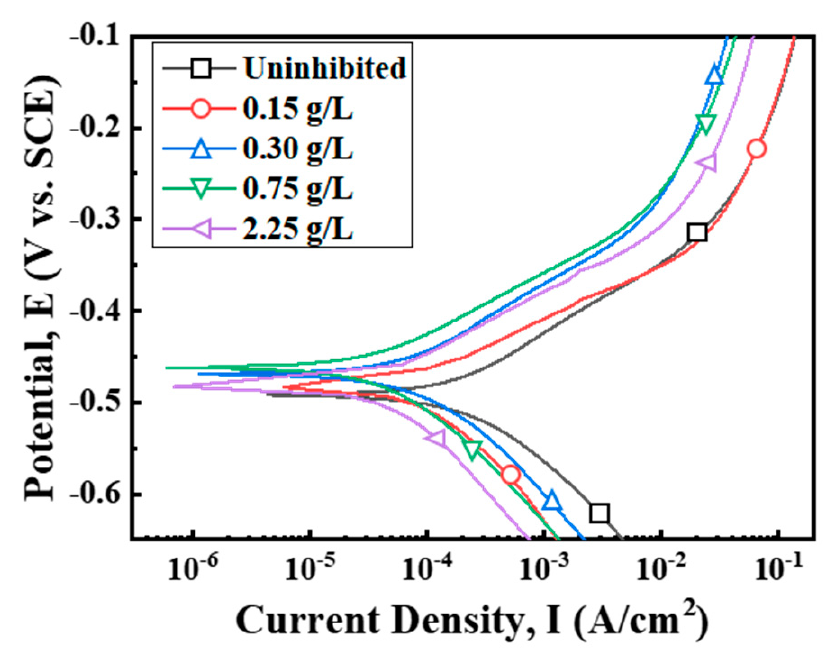
Figure 4. Polarization curves for mild steel specimen in 1 M HCl at 298 K with different concentrations of tea tree extract. Table 3. Corrosion data obtained from the electrochemical corrosion tests in Figure 4.